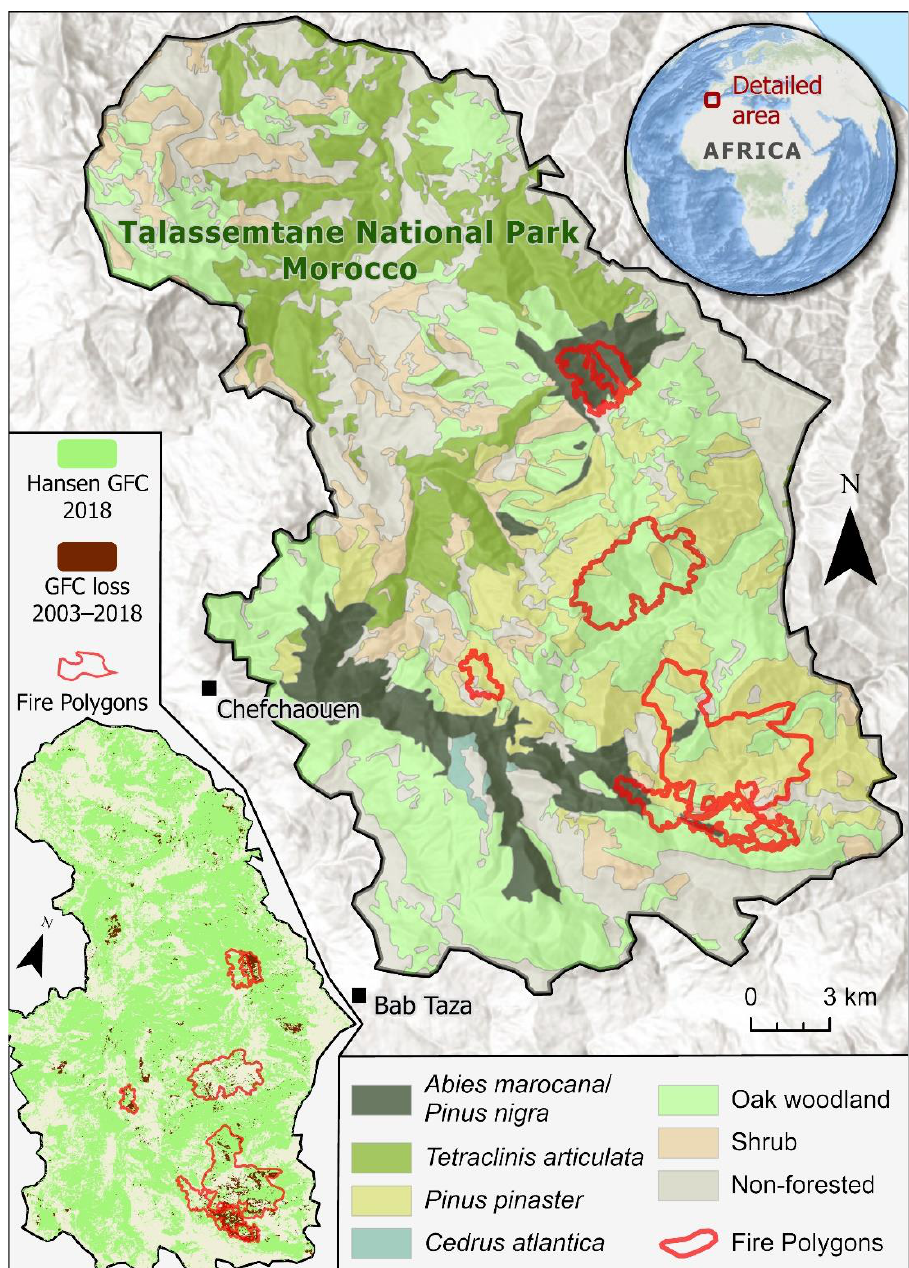
Figure 1. Talassemtane National Park with forested vegetation and fire polygons. Inset: Global Forest Change (GFC) map showing forested area, forest loss over the study period (2003 – 2018), and fire polygons.